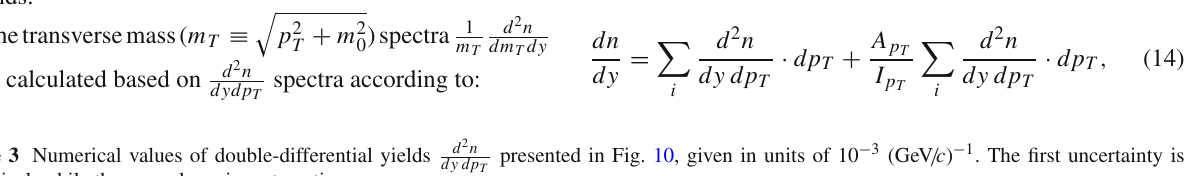
presented in Fig. 10, given in units of 10 − 3 (GeV / c ) − 1 . The first uncertainty is dydp T